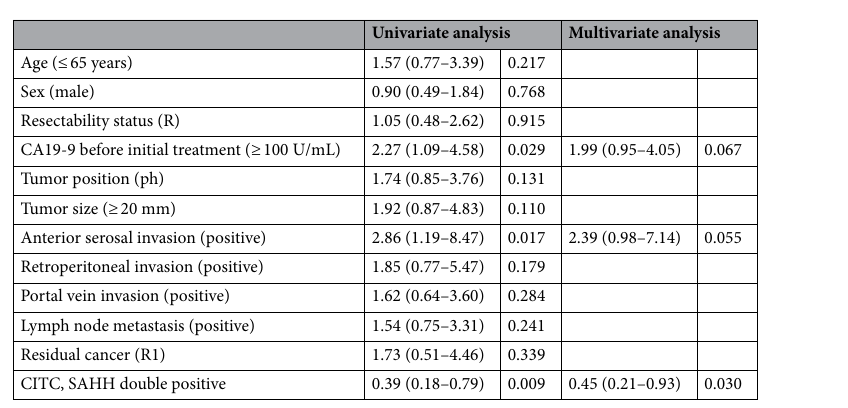
Table 3. Univariate and multivariate analyses of risk factors for